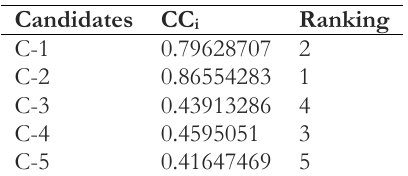
Table 17. The ranking of candidates with TOPSIS for the first sensitive analysis.